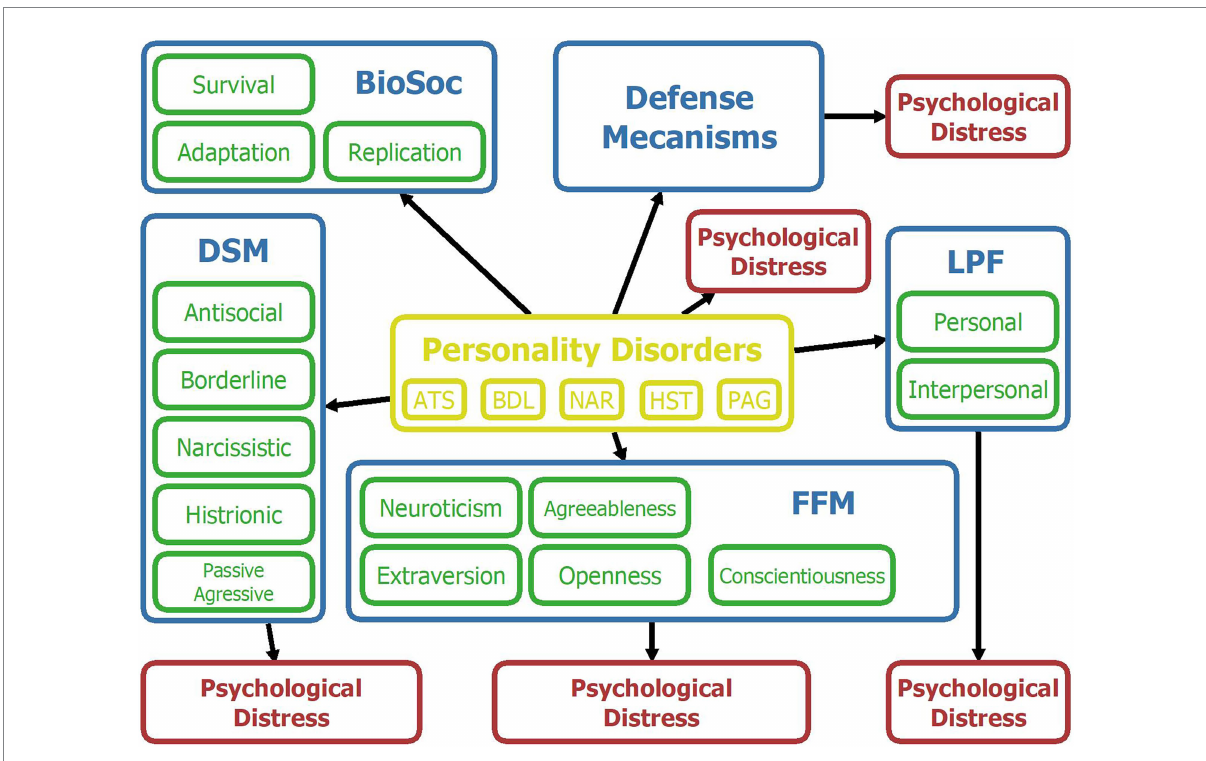
FIGURE 2 Map of variables for the Bayesian network. Yellow = Personality disorders; Blue = Psychological framework; Green = upper-level psychological constructs of a given framework; Red = Psychological distress. ATS = antisocial; BDL = borderline; NAR = narcissistic; HST = histrionic; PAG = passive- aggressive; BioSoc = Biosocial; DSM = Diagnostic and Statistical Manual of mental disorders; FFM = Five-Factor Model; LPF = Level of Personality Functioning.